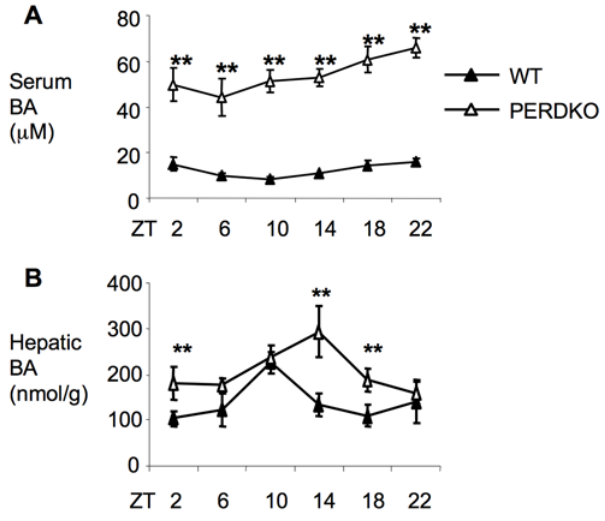
Figure 5. Bile acid dysregulation in PERDKO mice. A. Serum (n=6–8 each time point) and B. hepatic bile acid levels in PERDKO mice (n=3–5 each time point). **P , 0.01.